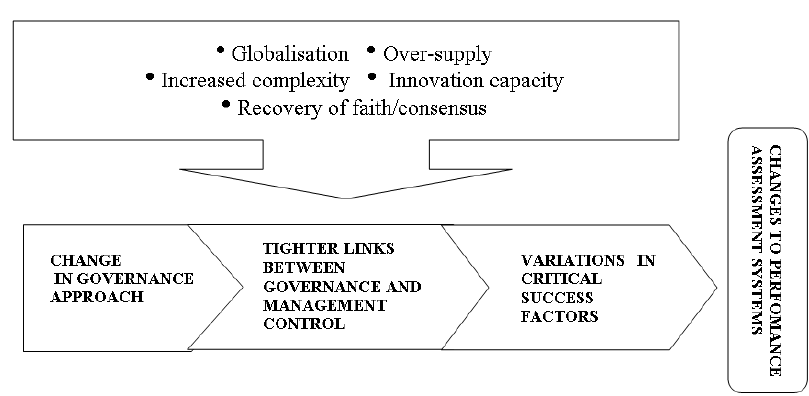
Figure 1: Impact of New Outlooks on Governance and